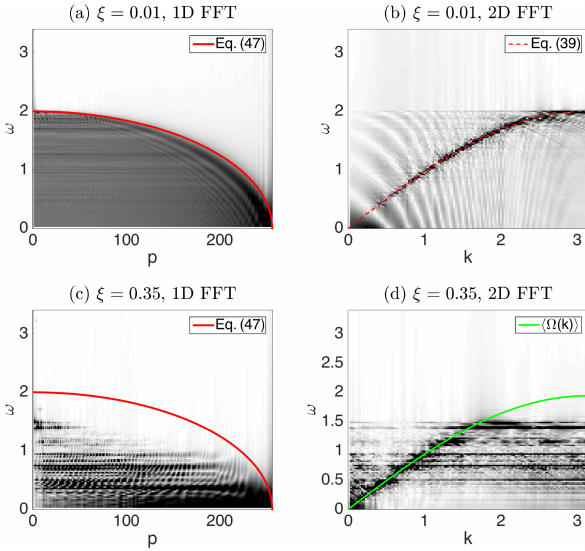
Figure 8. Wave speed for common distance of separation (seven particles or elements) with different disorder ξ . Note that the ver- tical range in (a, c) is different from (b, d) . Red line is 70% of the peak value and blue line gives the velocities when the peak is considered.